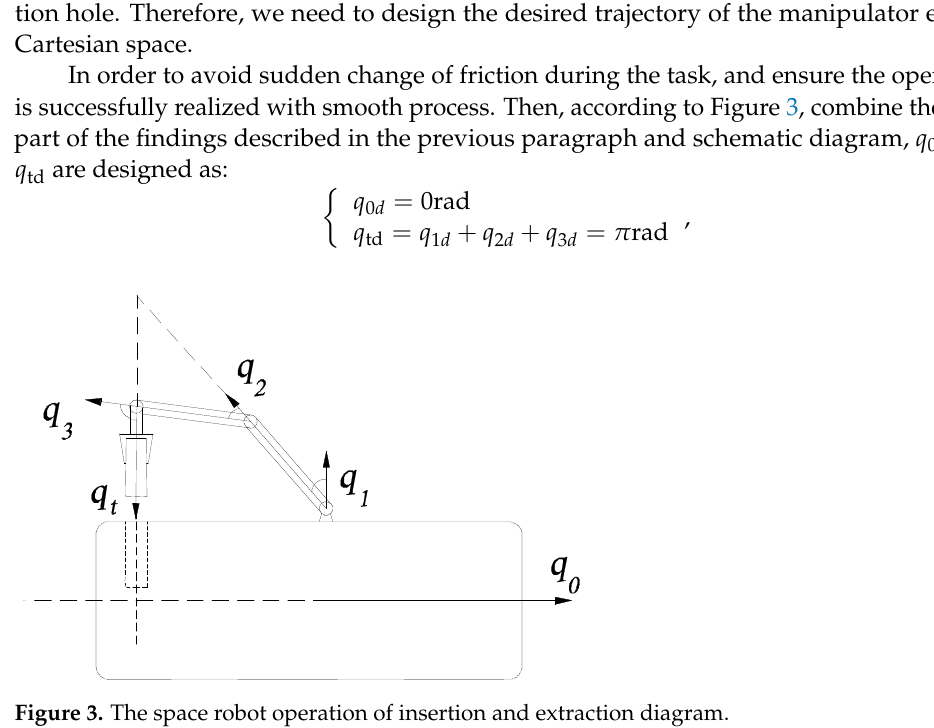
Figure 3. The space robot operation of insertion and extraction